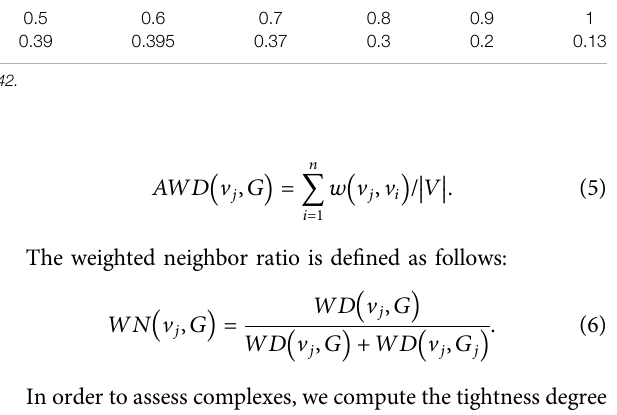
TABLE 4 | Each algorithm identi fi es the cluster information. No.